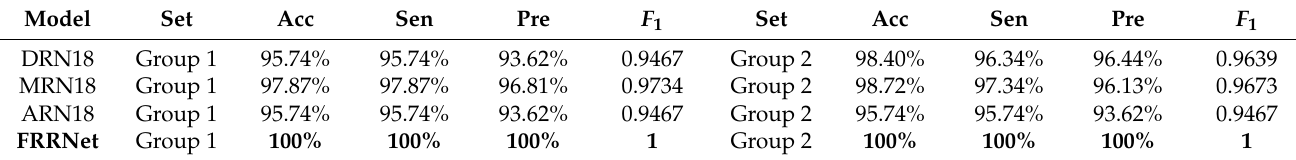
Table 5. Identification accuracy